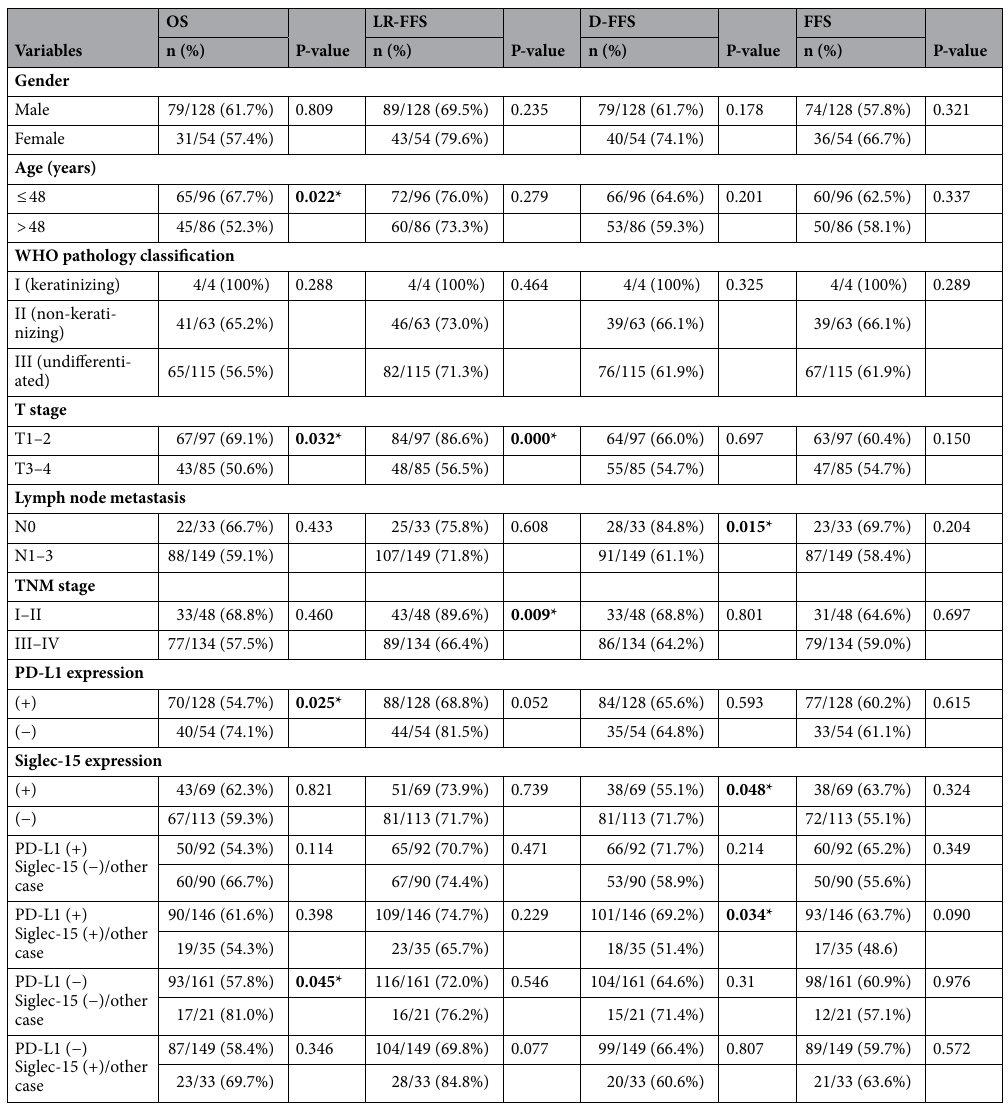
Table 3. The association between clinicopathological variables and disease outcome. Siglec-15 Sialic acid- binding immunoglobulin-like lectin 15, PD-L1 programmed cell death-Ligand 1, WHO World Health Organization, OS overall survival, FFS failure-free survival, LR-FFS , local regional failure-free survival, D-FFS distant failure-free survival. The bold value represents p>0.05, indicating that the difference is statistically significant.